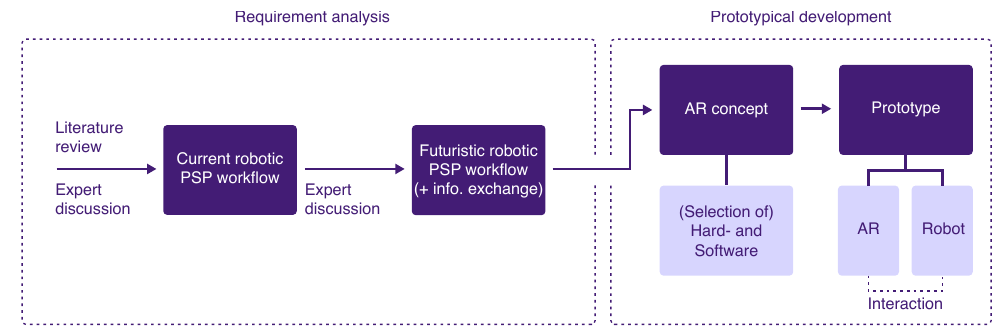
Figure 2. Methodical approach of the project including the analysis of requirements and prototype